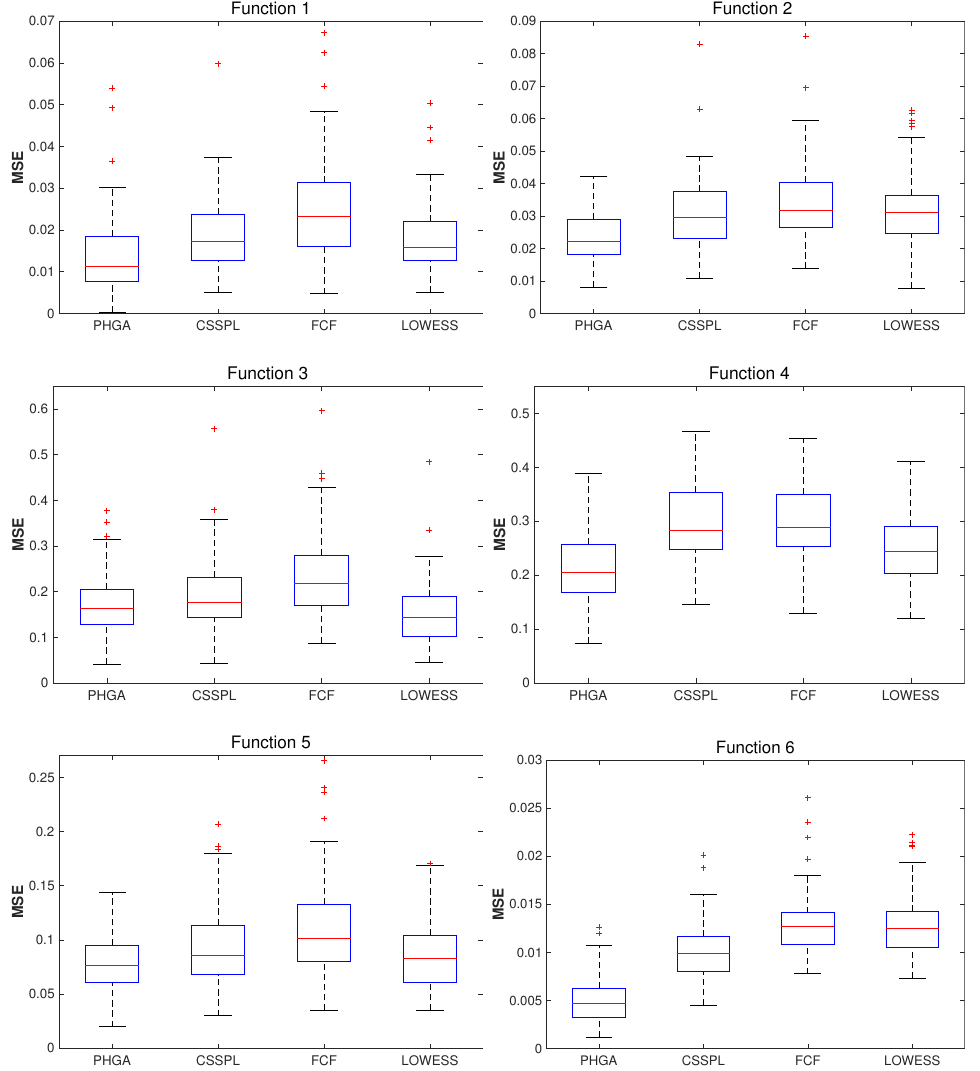
Figure 6. Boxplots of MSE computed for each algorithm by function, using 100 test sets, 100 scatered points(x,y) and SNR =